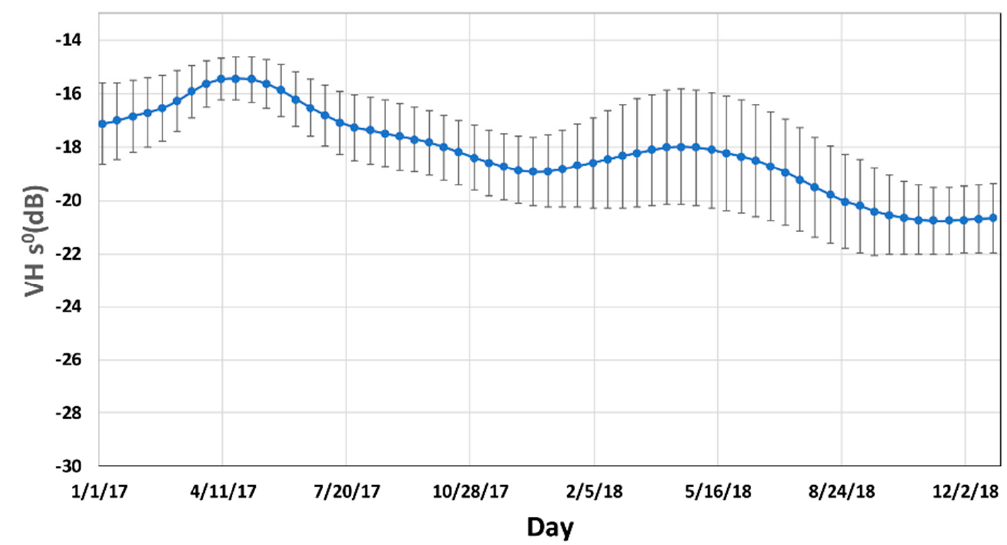
Figure 11. The average time series behavior with the respective standard deviation bars for areas during the fallow period between rice cultivation, without showing the typical characteristic of the beginning of planting.